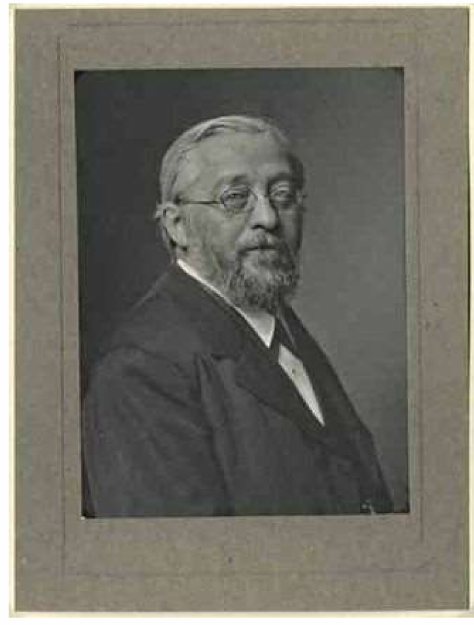
Figure 5. Paul Heinrich von Groth (https: // de.wikipedia.org / wiki / Paul_Heinrich_von_Groth). Fedorov signed his letters to Groth di ff erently: till 1896 mostly “E. Fedorow”; 1896–1898